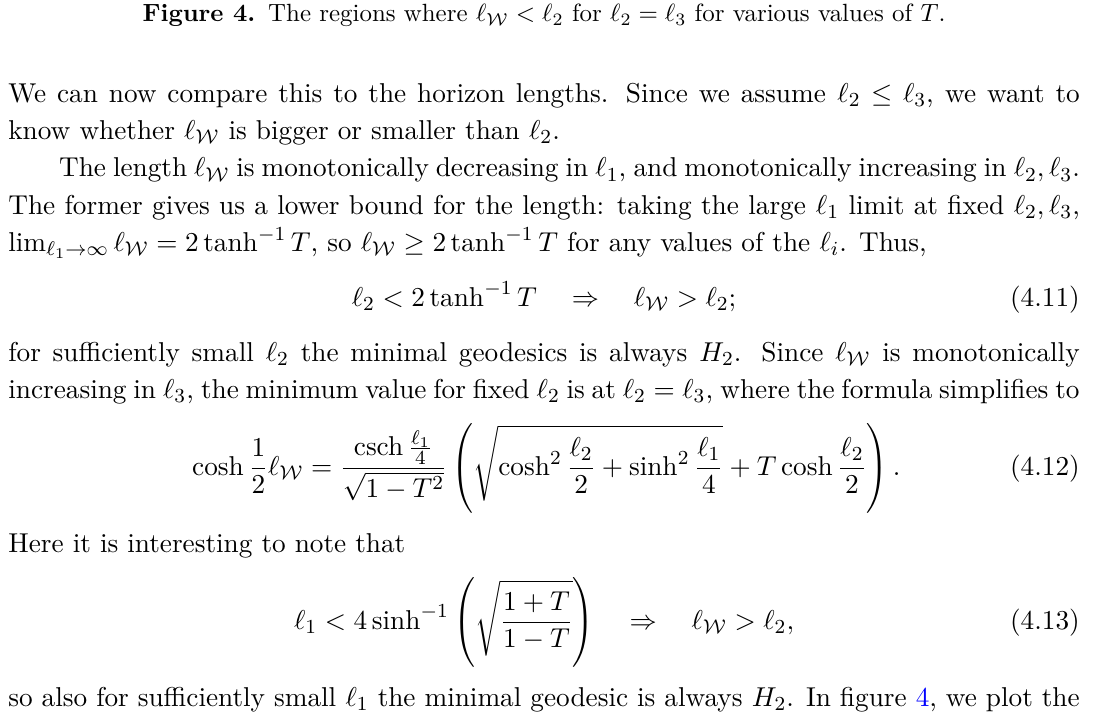
Figure 4. The regions where ‘ W < ‘ 2 for ‘ 2 = ‘ 3 for various values of T